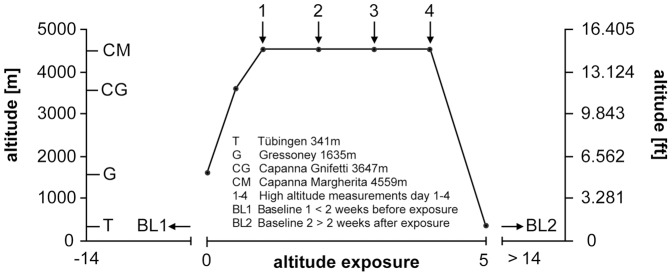
Ascent profile.The graph represents the ascent profile of volunteers to the research facility of the Capanna Margherita (4559 m). Numbers indicate all four measurements using the CIP at high altitude. Before and after the ascent to the Capanna Margherita baseline measurements were performed.